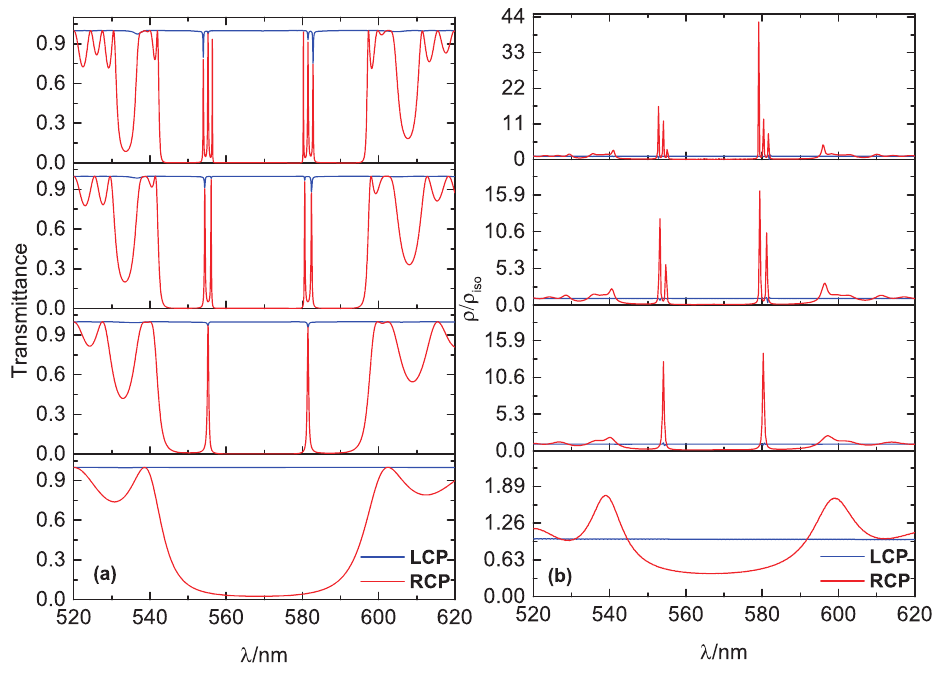
Figure 6. ( a ) calculated transmission spectra for RCP light (red) and LCP light (blue) for composite structures with 0, 1, 2, and 3 defect layers; ( b ) calculated relative DOS ρ / ρ iso for RCP and LCP